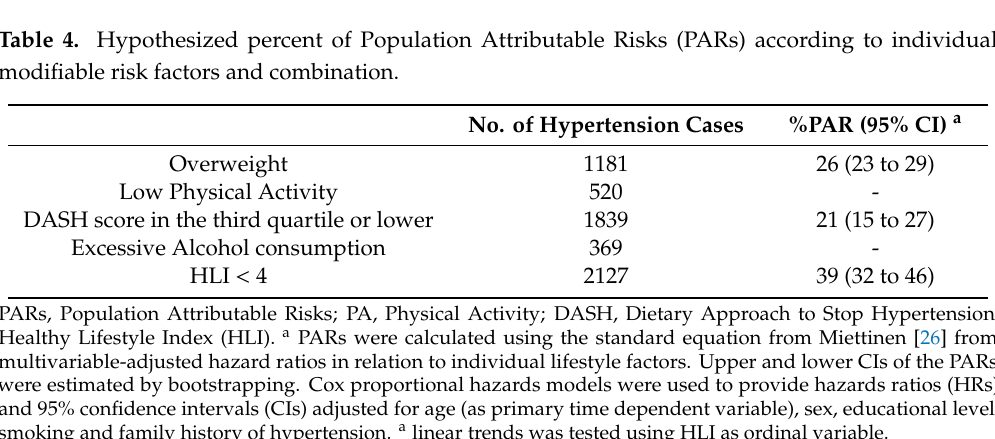
Table 4. Hypothesized percent of Population Attributable Risks (PARs) according to individual modifiable risk factors and combination.